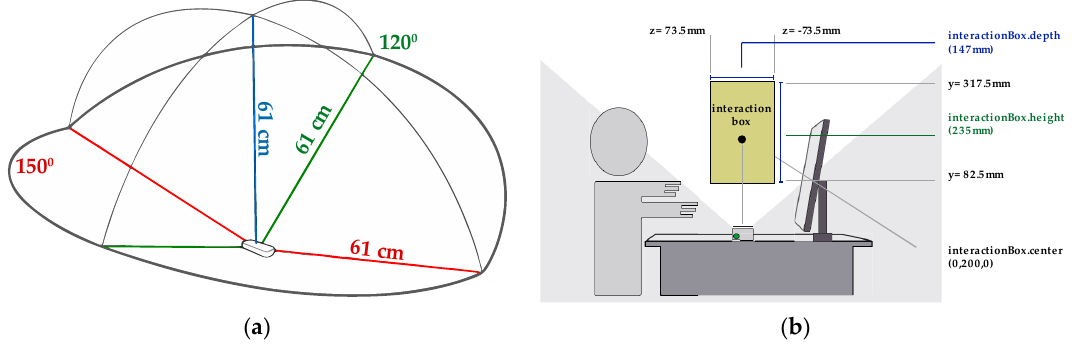
Figure 10. ( a ) Interaction area of Leap Motion. ( b ) Interaction box of Leap Motion.